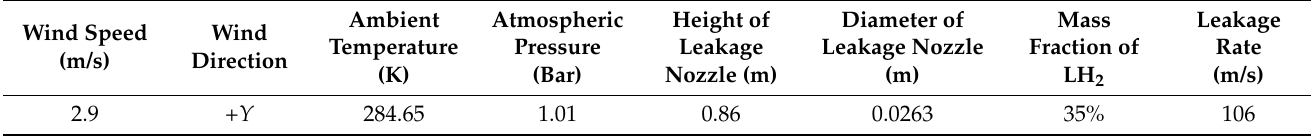
Table 3. Experimental condition of test7 by